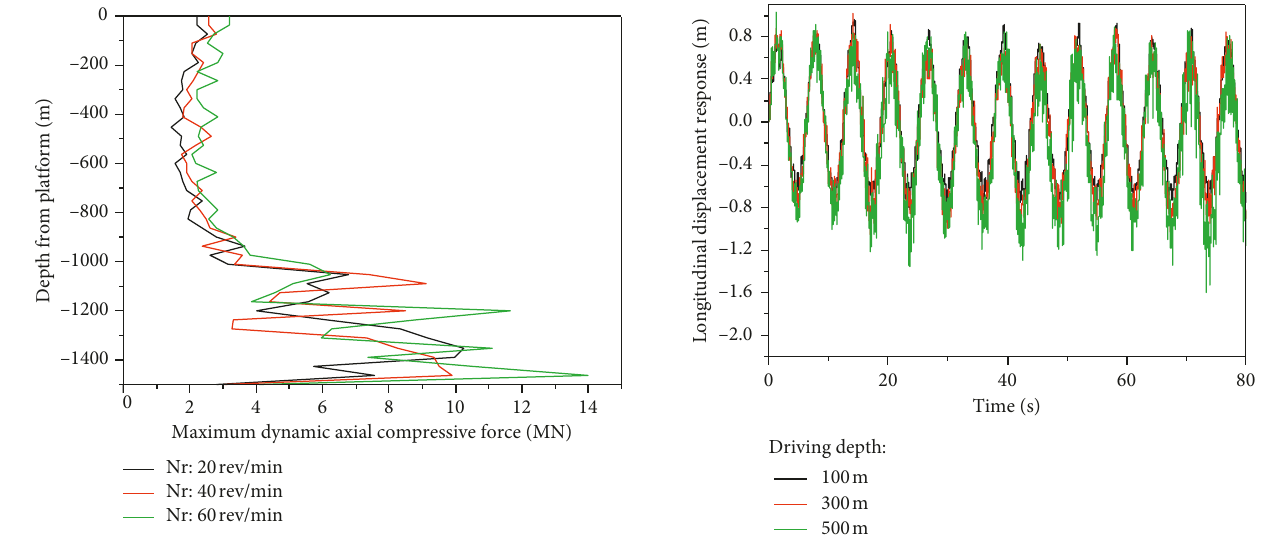
Figure 23: Effect of bit speed on transverse compressive response.